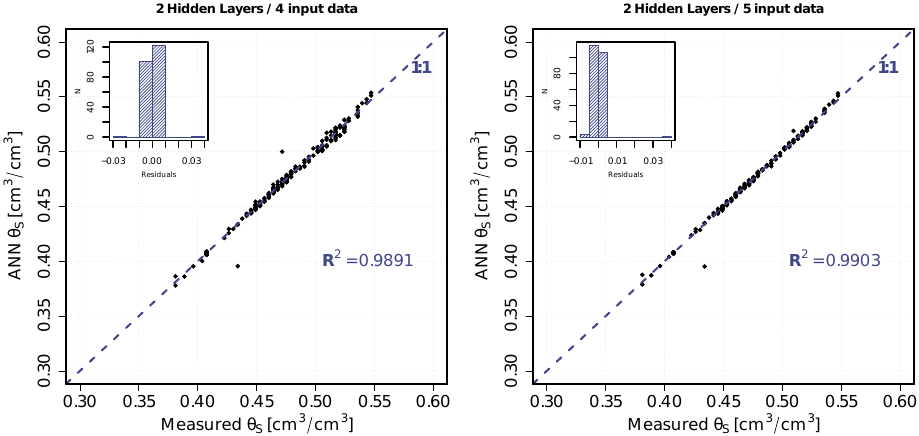
Figure 6. Results for the 4-9-10-1 ( left ) and 5-10-10-1 ( right ) configuration predictions applied in the validation